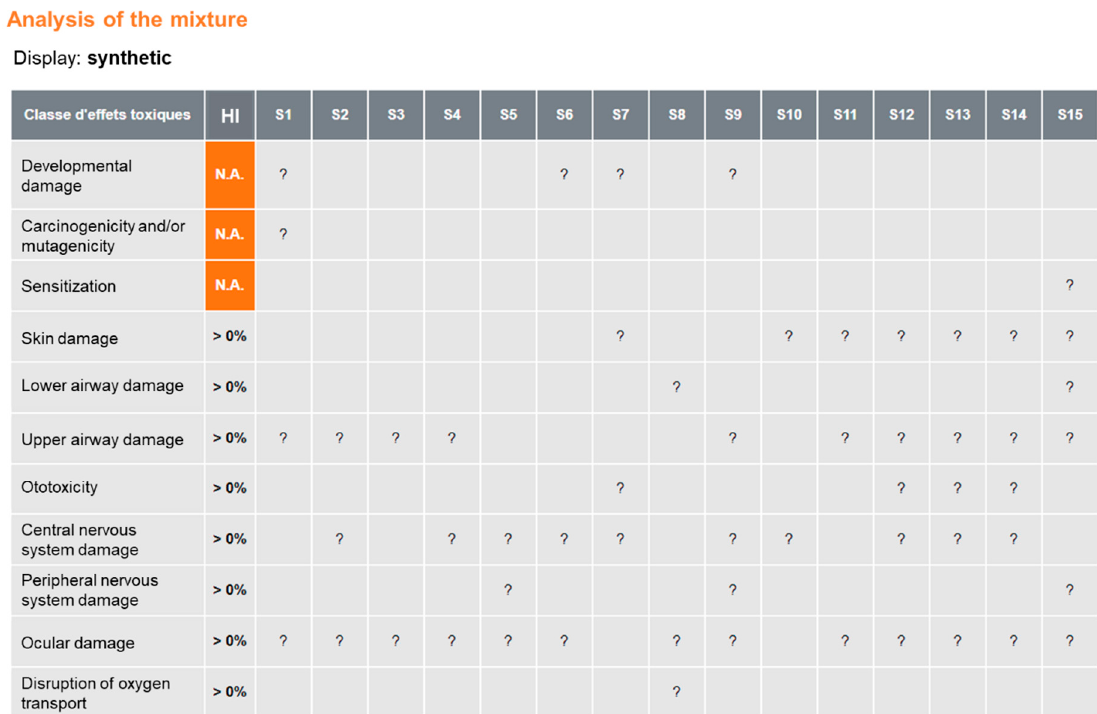
Figure 4. Mixture analysis without atmospheric concentrations (qualitative mode: Hazard Indexes of each toxicological class and ratios of individual substances within classes are not calculated: >0% and ?, respectively).